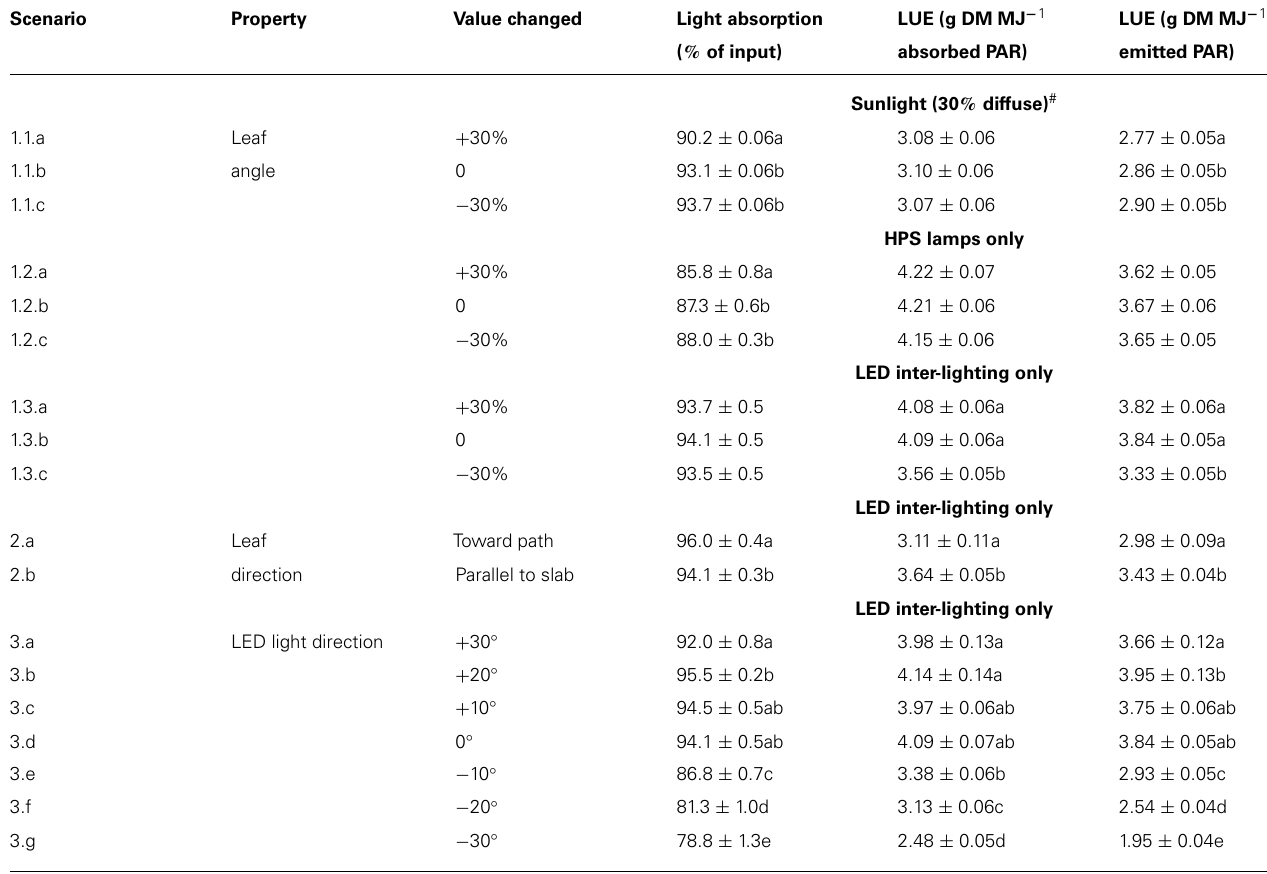
Table 1 | Light absorption ( % of input) and light use efficiency (LUE) per unit absorbed or emitted light per mentioned light source of the tomato crop for the different scenarios.Within each group (1.1, 1.2, 1.3, 2, or 3) letters behind a mean indicate a significant difference between scenarios ( p < 0.05). DM, dry